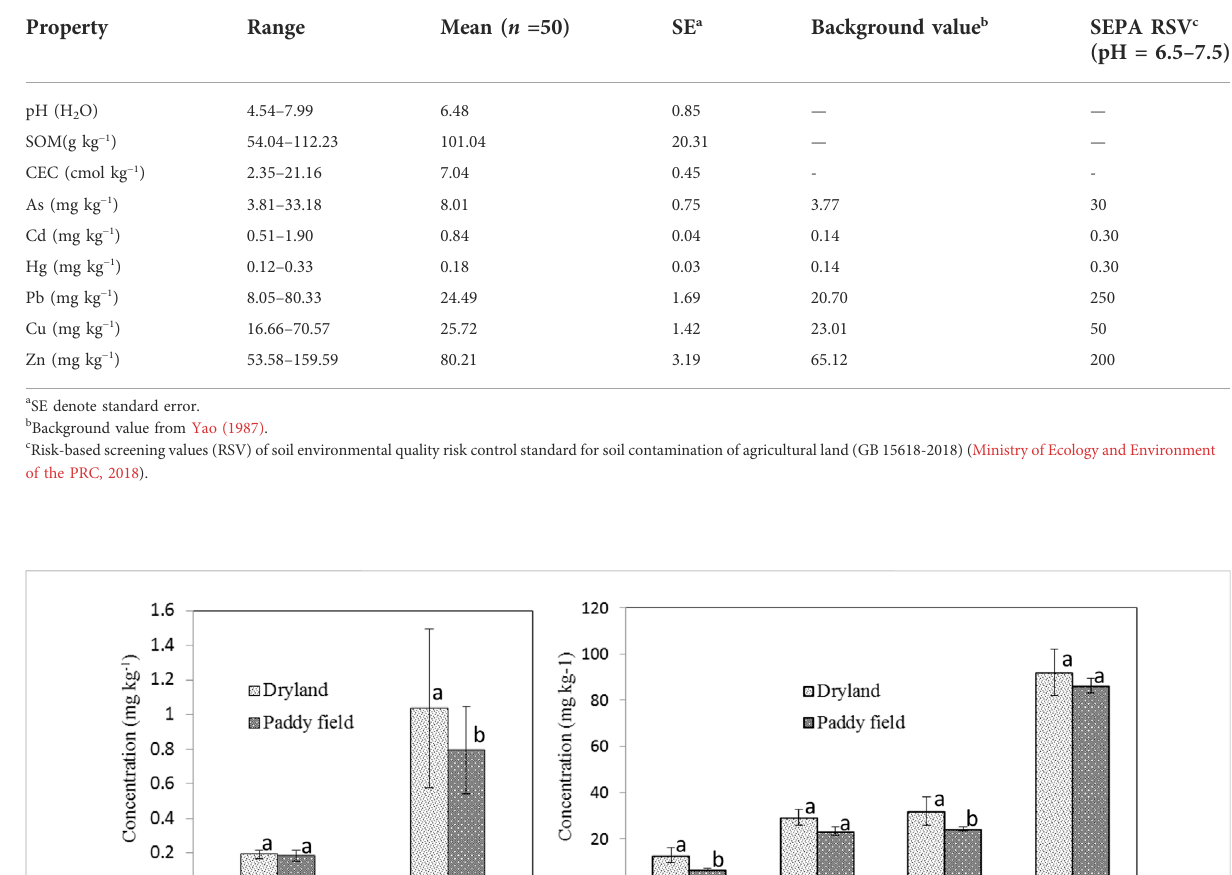
TABLE 1 Characteristics and metal levels of the soils collected from the study area (matters content on dry weight basis).